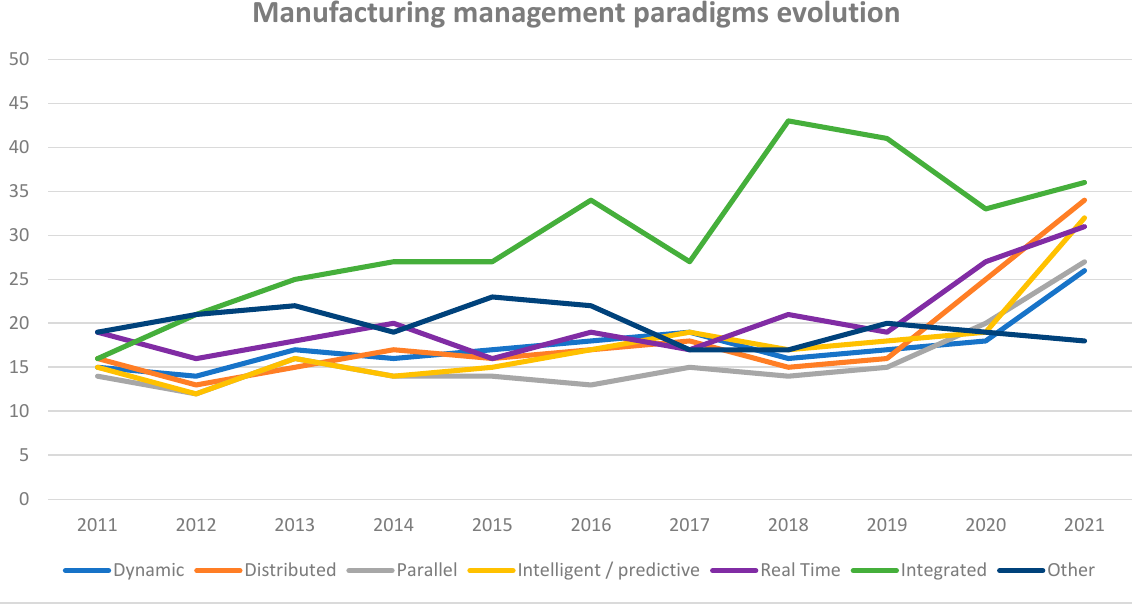
Figure 3. Progression of the number of publications about manufacturing management paradigms from 2011 to 2021.